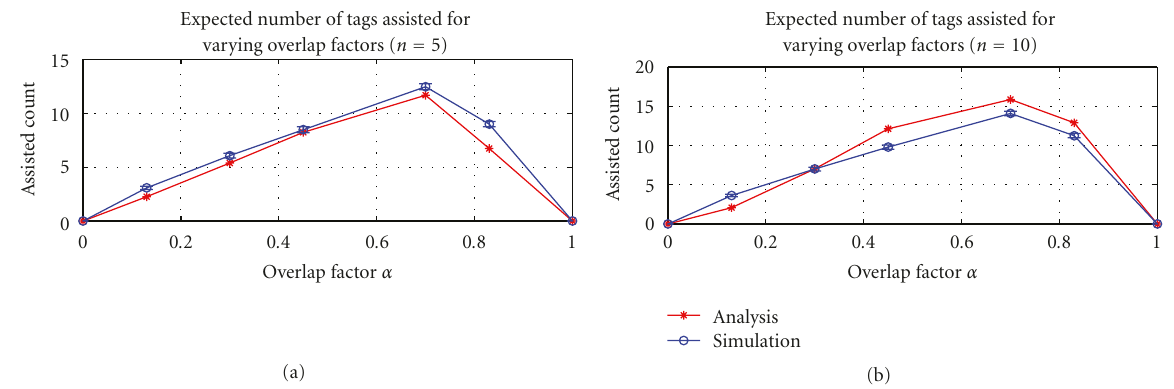
Figure 16: Comparison of the assist e ff ect for the first round of queries for n = 5,10 as a function of varying overlap factor, α.